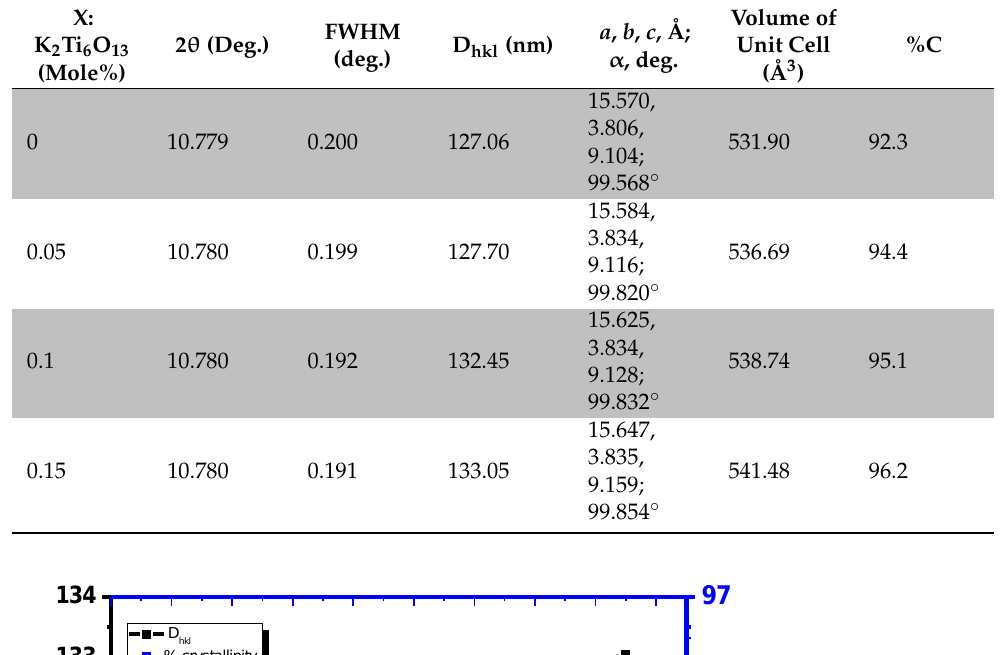
Table 1. Various structural parameters of K 2 Ti 6 O 13 and Co x :K 2 Ti 6 O 13 ceramics (x = 0.0, 0.05, 0.1, and 0.15 mole%) at room temperature.